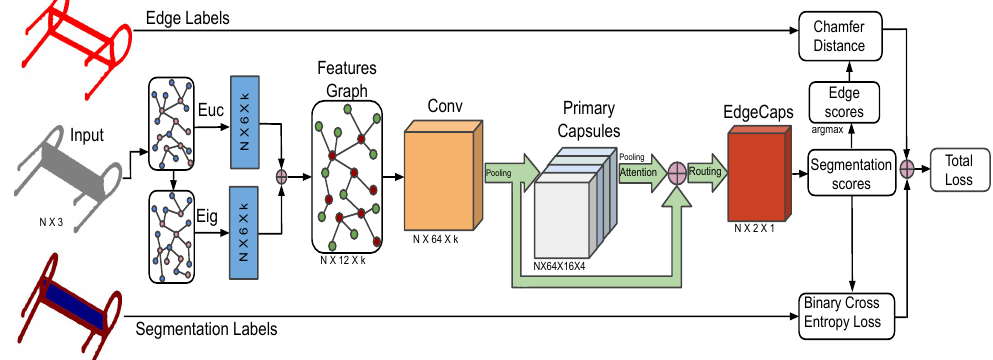
Figure 1. Overall overview of the proposed EDC-Net architecture. The input of this architecture is a raw point cloud of dimension N × 3. The ground-truths are edge labels and segmentation labels which distinguish edges and non-edges points as two classes. The features graph is an aggregation neighborhood graph based on a concatenation of features from euclidean and eigenvalues spaces. EdgeCaps module proceeds with point-wise segmentation to classify edge and non-edge points. ⊕ stands for